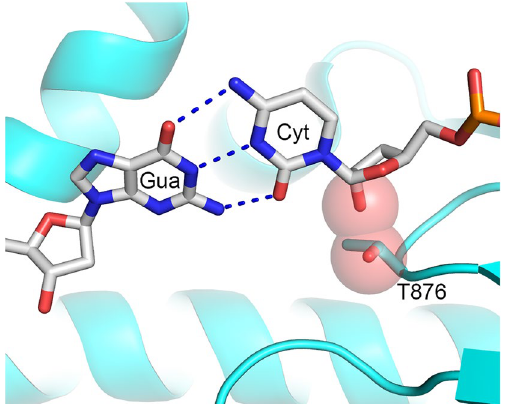
Figure 7. Polε has a steric gate for the 2 ′ -hydroxyl of a primer. The protein is represented as cartoon and colored cyan; Thr876 is shown as sticks. The template and primer are shown as sticks and colored blue for nitrogen, red for oxygen, orange for phosphorus, and grey for carbon. The O1 of Thr876 and modeled O2 of primer Cyt are presented as spheres with 60% transparency and colored red. The interception of spheres indicates steric hindrance. The crystal structure of the ternary complex of yeast Polε CD with DNA and dCTP (pdb code 6hiv (22)) was used for this presentation prepared with the PyMOL Molecular Graphics